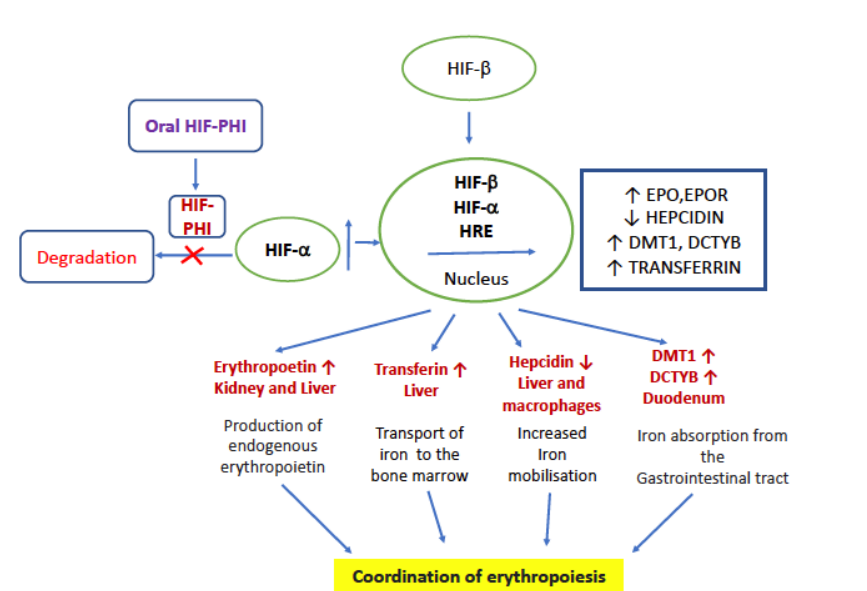
Figure 1. Mode of action of HIF-PHI. EPO—erythropoietin, EPOR—erythropoietin receptor, DCYTB, duodenal cytochrome B; DMT1, divalent metal transporter, HRE—hypoxia responsive element, and HIF—hypoxia inducible factor.